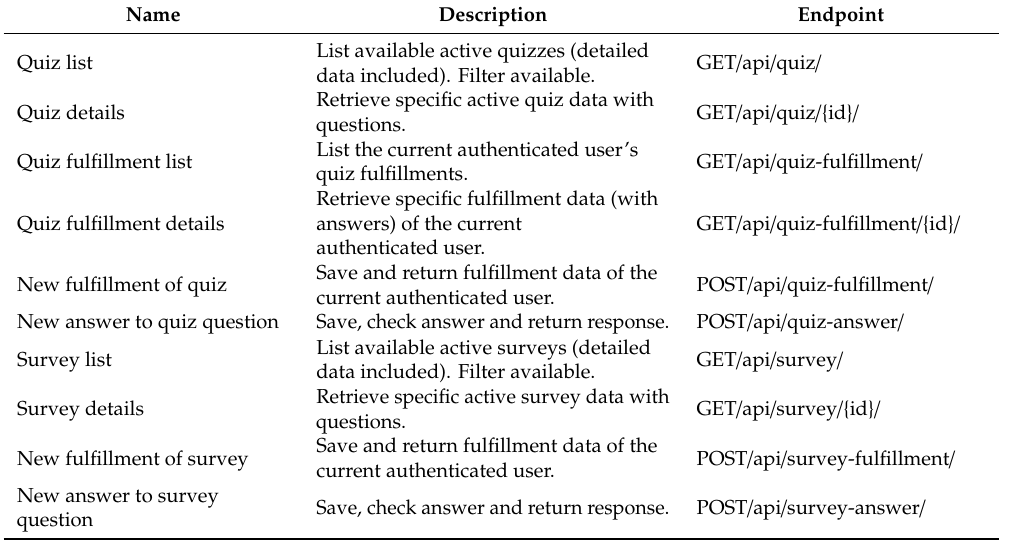
Table 4. Quiz and survey